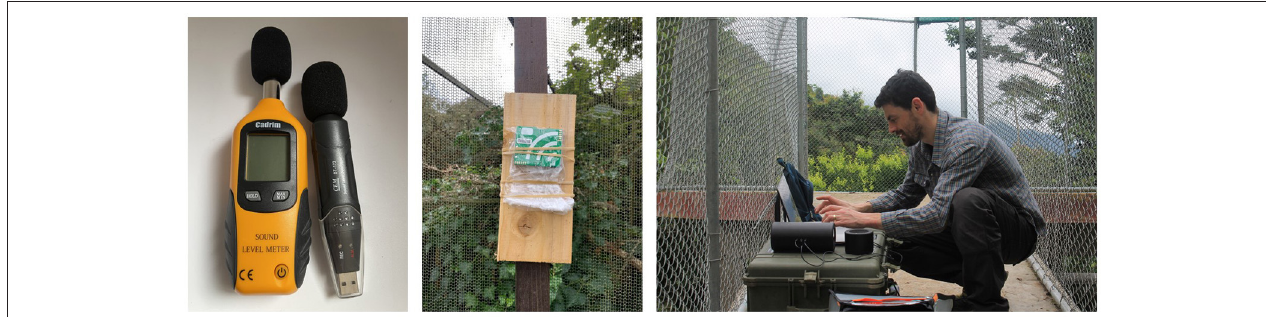
FIGURE 4 | Equipment for acoustic research on captive animals. Left: handheld and static sound pressure level (decibel) loggers with foam windshields. Middle: an autonomous recording unit (Audiomoth) inside a waterproof sleeve, installed on a zoo enclosure to record the soundscape. Right: acoustic playback equipment consisting of a speaker and sound recorder pointed toward an enclosure. Photo credits: FE Clark, F Steinbrecher, JC Dunn.